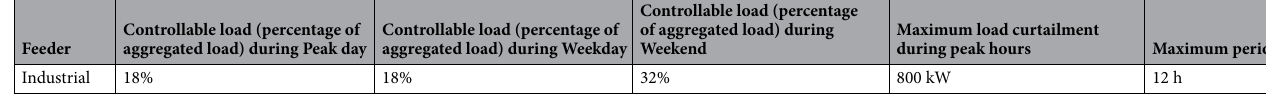
Table 4. Schedulable load data.